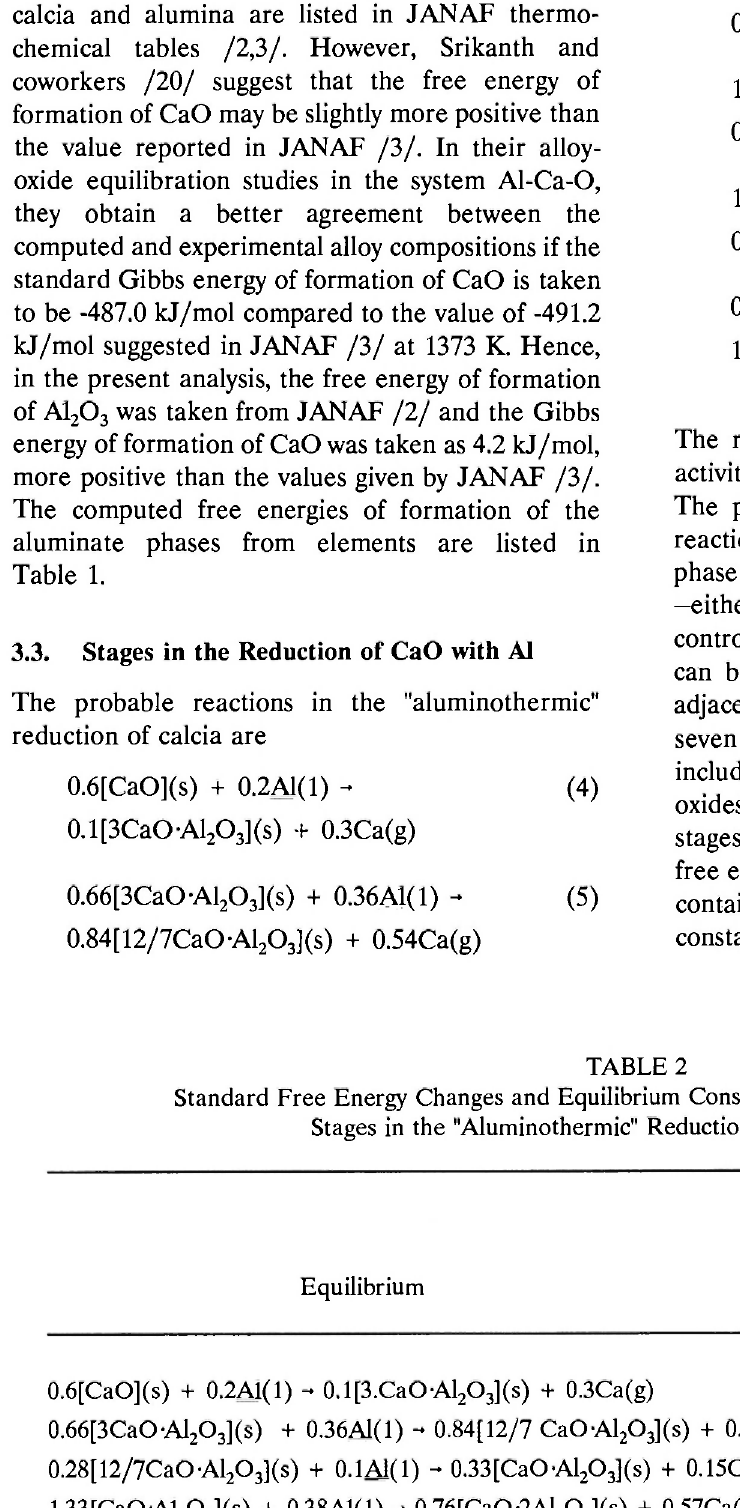
Standard Free Energy Changes and Equilibrium Constant Characterizing the Reduction Stages in the "Aluminothermic" Reduction of Calcia at 1373 Κ